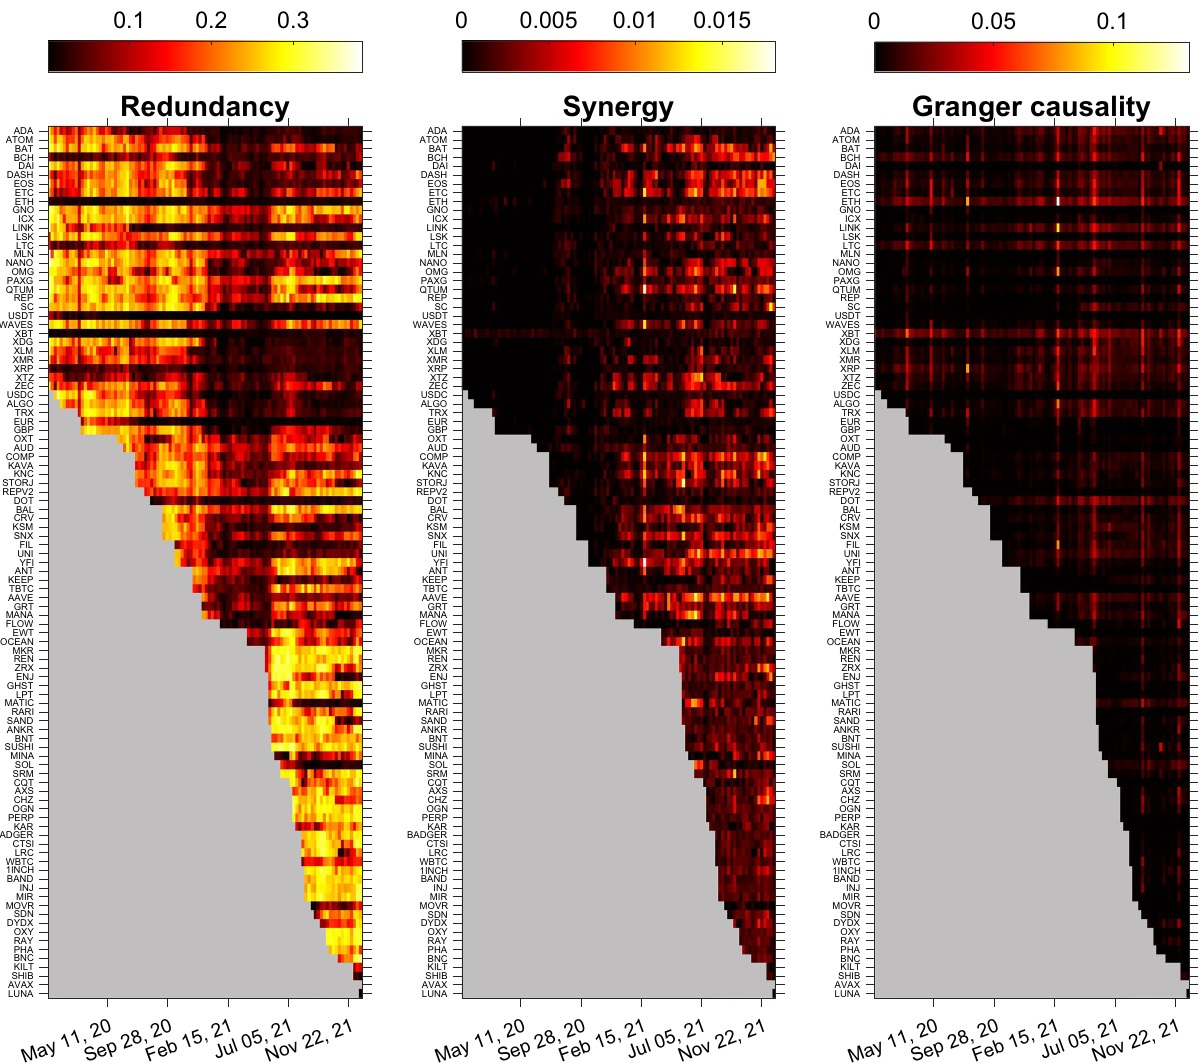
Figure 8. The redundant (left) and synergistic (center) dynamical O-information toward various targets, where each point represents the value of d (cid:31) ˜ X 5 → y of the best multiplet of sources ˜ X 5 that conveys the highest and lowest O-information toward the target y . We also depict the out strength Granger causality (right) for each weekly window. Regions in grey represents windows where that cryptocurrency was not yet